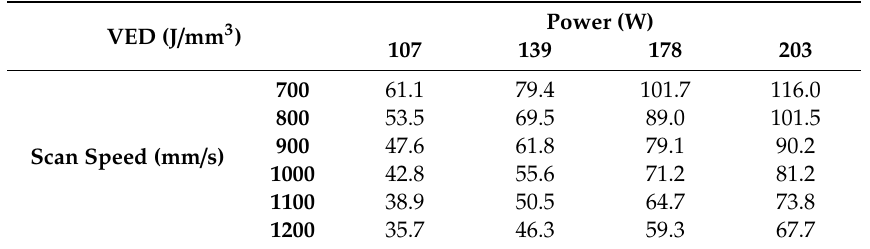
Table 2. Parameters matrix used for optimization of the SLM process (power and scan speed were variables while beam dimeter (50 µ m), hatch spacing (50 µ m), layer height (50 µ m), and shift angle (45 ◦ ) were